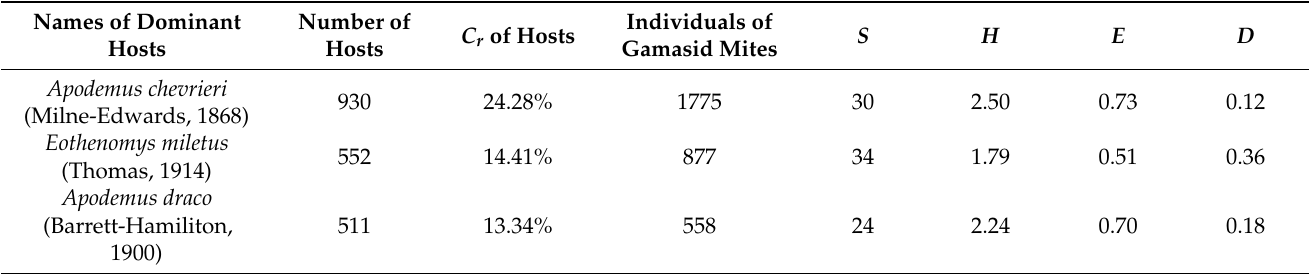
Table 3. Statistics on community structure of gamasid mites on three dominant species of small mammals in Three Parallel Rivers Area in northwest Yunnan of China (2001–2015).